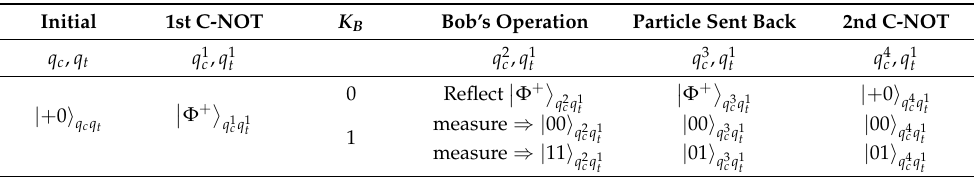
Table 1. States transformation during the double C-NOT attack.